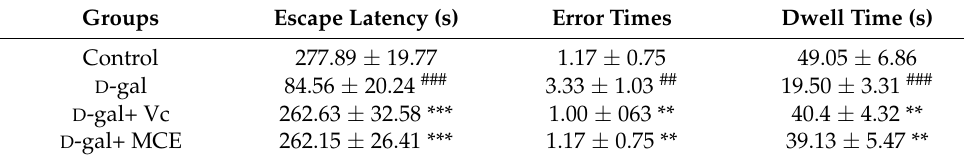
Table 3. Effects of MCE on escape latency and error times of step-down